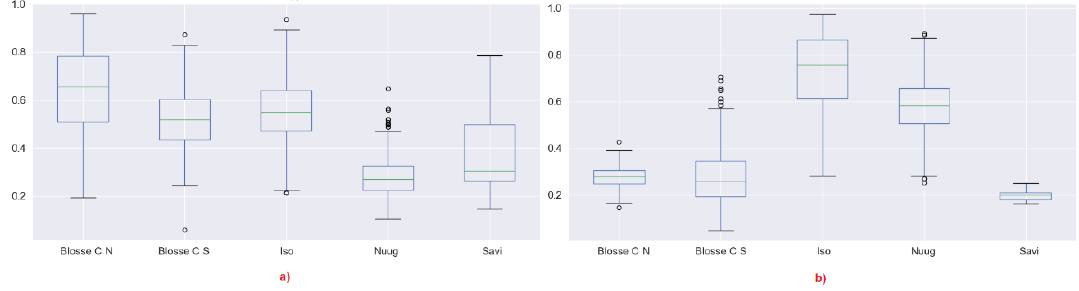
Figure 8. ( a ) Iceberg entropy boxplot 5 × 5 window, ( b ) 11 × 11 window. Large entropy changes are most significant in Blosseville Coast N and Savissivik. Dots indicate outliers.